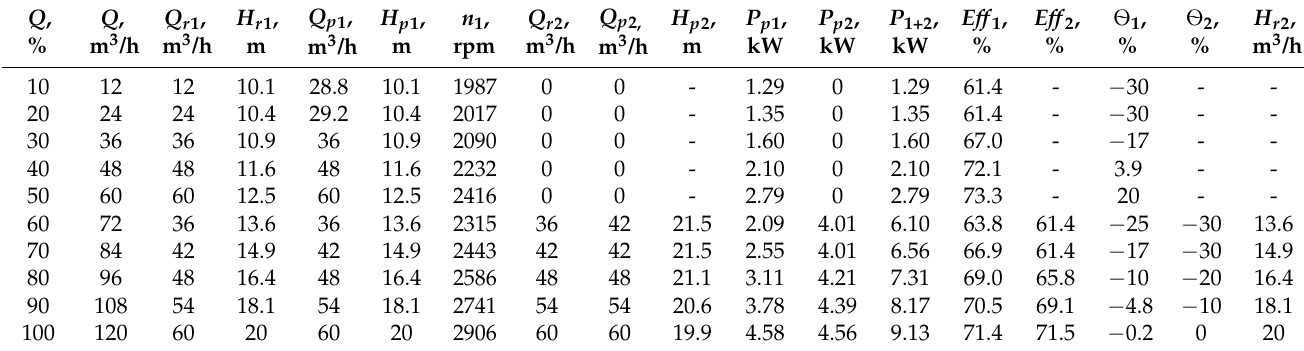
Table 4. Pump system performances applying the trade-off control.